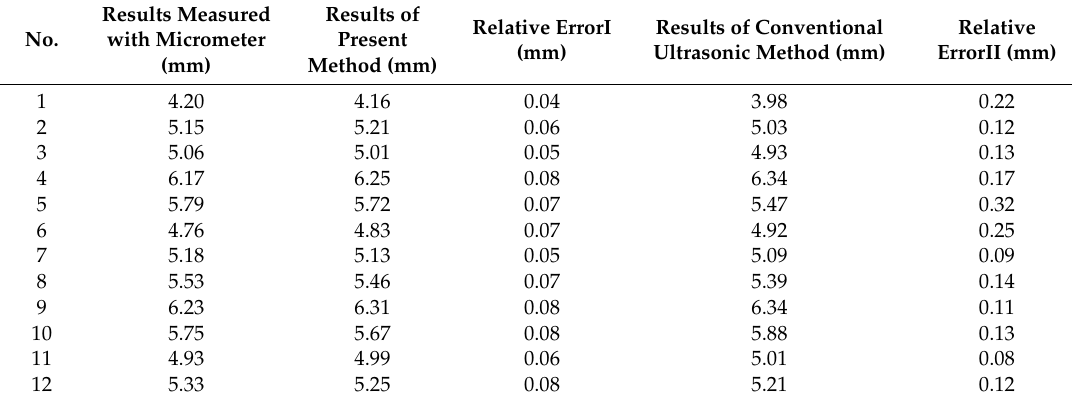
Table 2. Comparisons between results measured with three di ff erent methods.